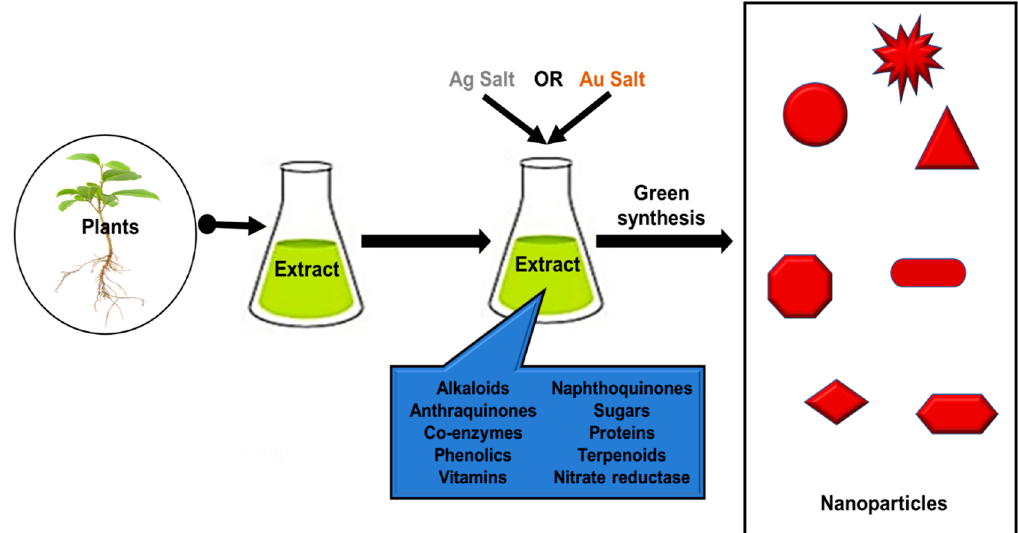
Figure 1. Schematic representation for the green synthesis of metal nanoparticles using different